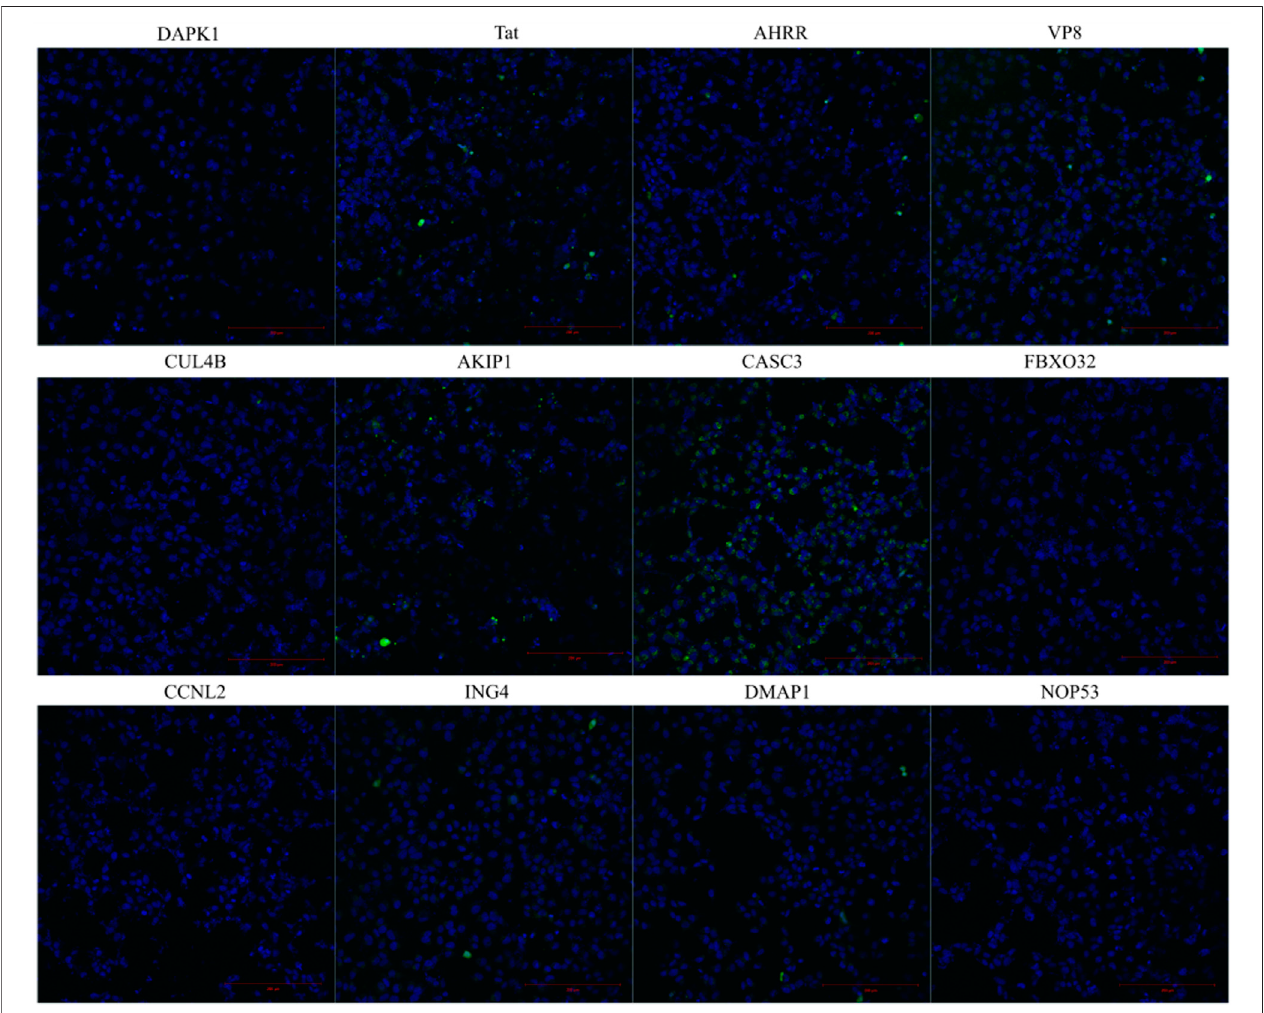
FIGURE 2 | Internalization of the fl uorescently labelled peptide into the HeLa cells. The images are taken from live cells 4 h after the addition of the fl uorescently labelled peptide to the cells. The peptide ’ s fi nal concentration on the cells was 10 µM. Hoechst was used to stain the nuclei.